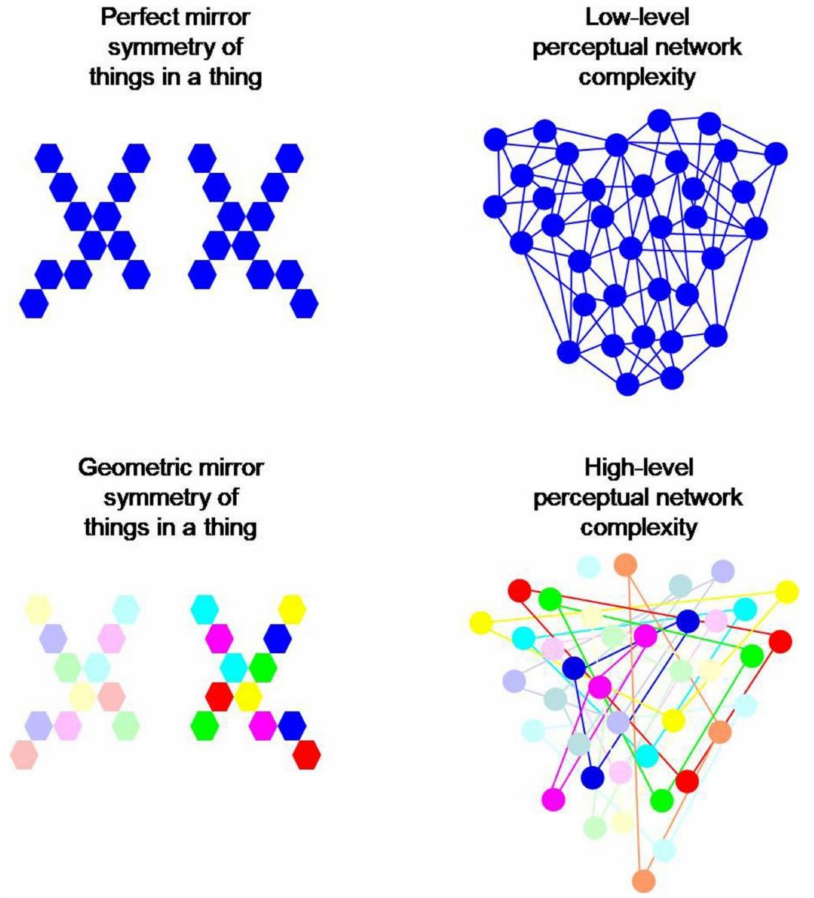
Figure 7. Local variability in color, saturation or contrast (bottom) across an axis of perfect geometric mirror symmetry involves higher levels of brain network complexity with longer processing times, by comparison with the same geometric configuration not presenting such variability (top). The complexity here originates from the initial complexity of contrast sensitive and wavelength selective computations at the level of visual neurons of the p-pathway in the retina (Figure 1), and affects all further brain computations at higher levels of